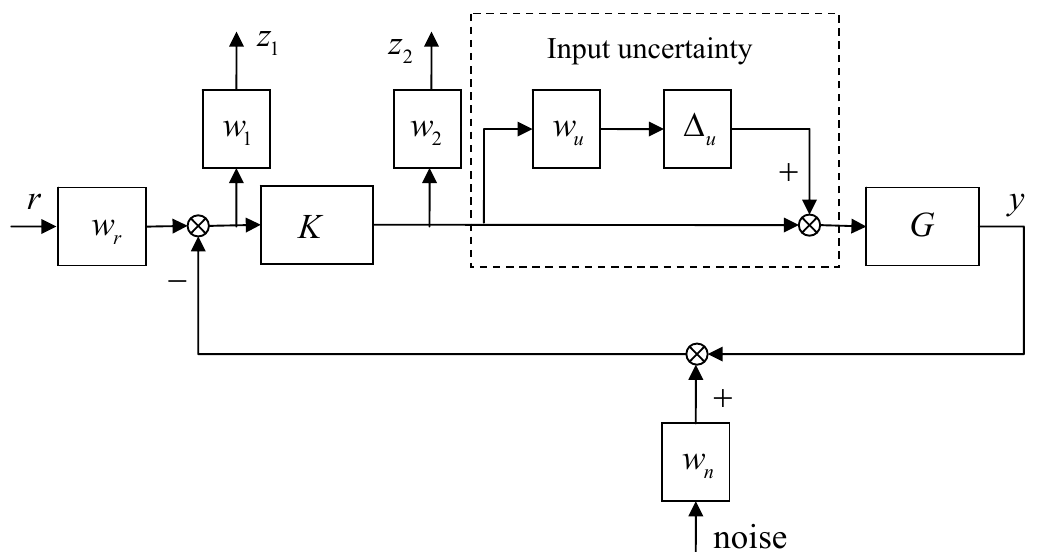
Figure 9. Design sketch of the robust H